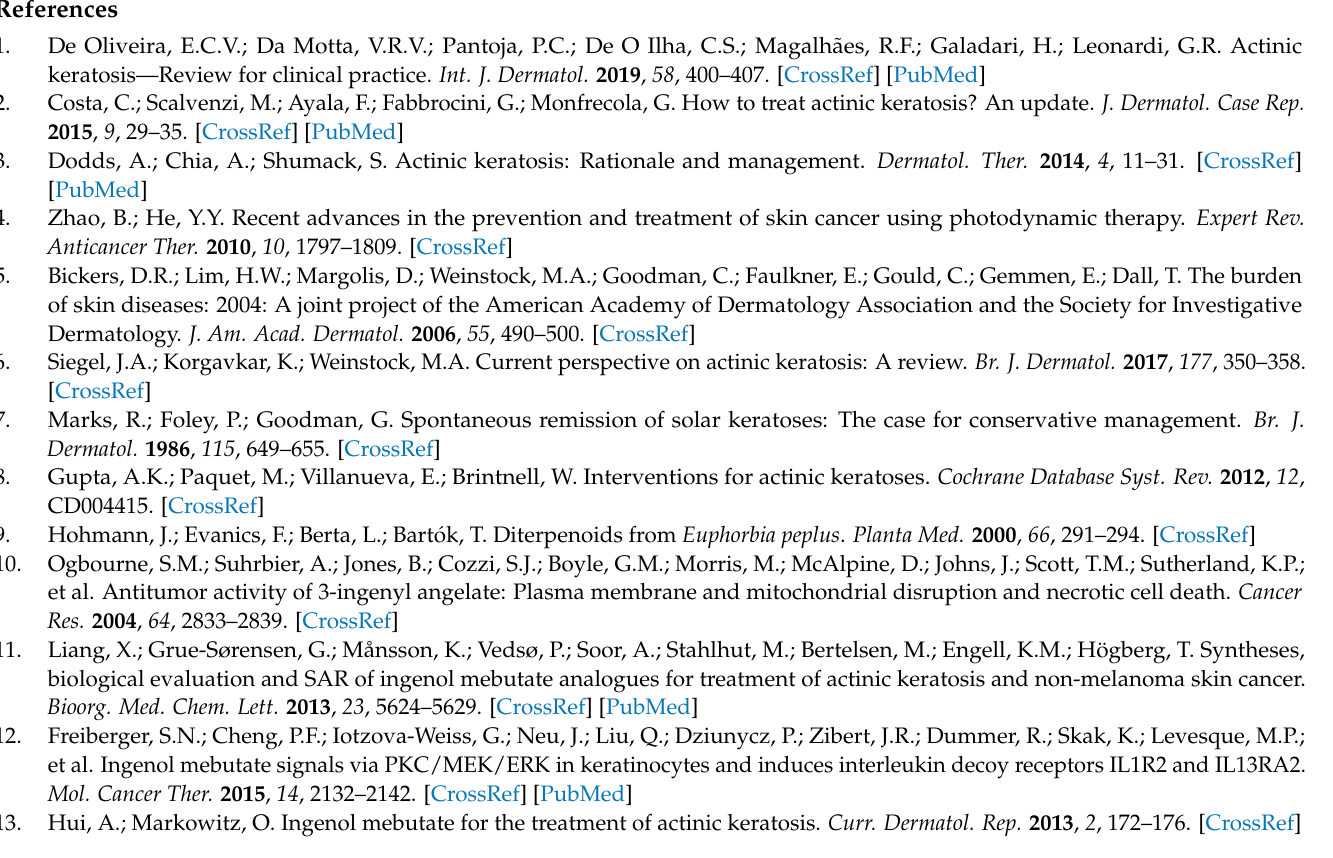
Figure S17: RTCA (real-time cell analysis) measurement of CI (cell index) values of HPV-Ker cells treated with compounds 1 , 2 , 4 + 5 , 6, and 9 . Normalized CI * hours values were plotted as a function of concentration of the indicated diterpenoid